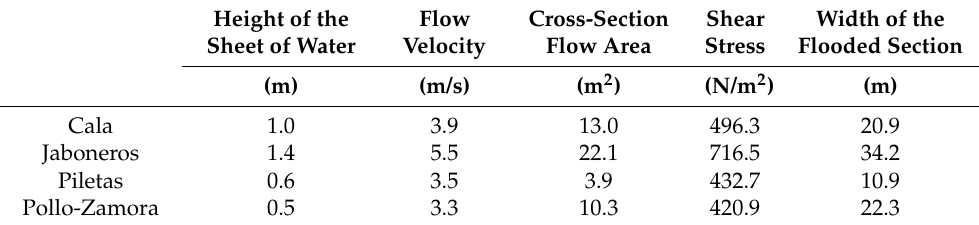
Table 4. Mean values of the hydraulic analysis in the control sections of each basin for a 500-year return